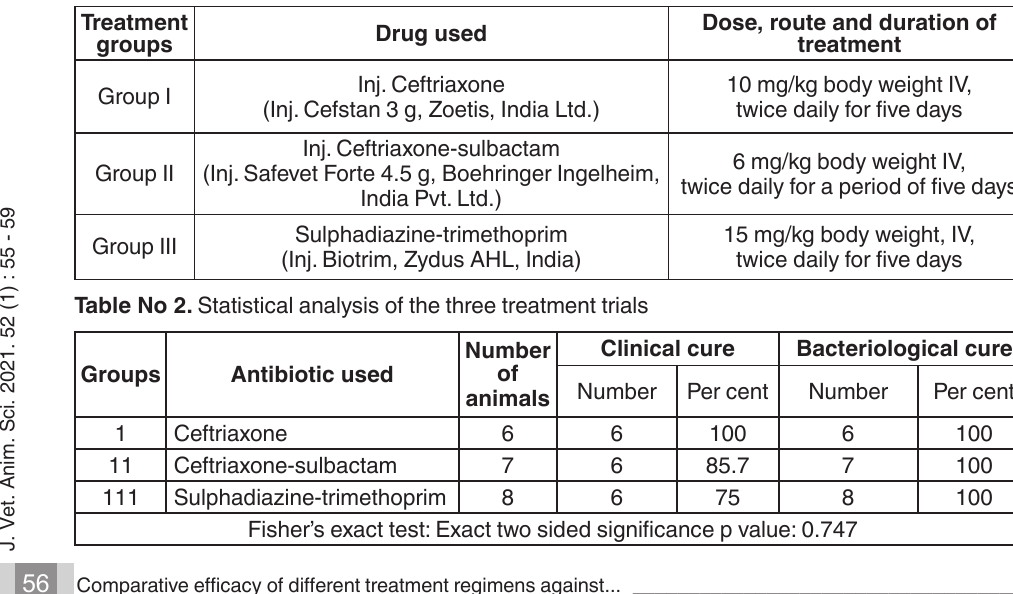
Table 1. Antimicrobial protocol used for treatment trial Treatment groups